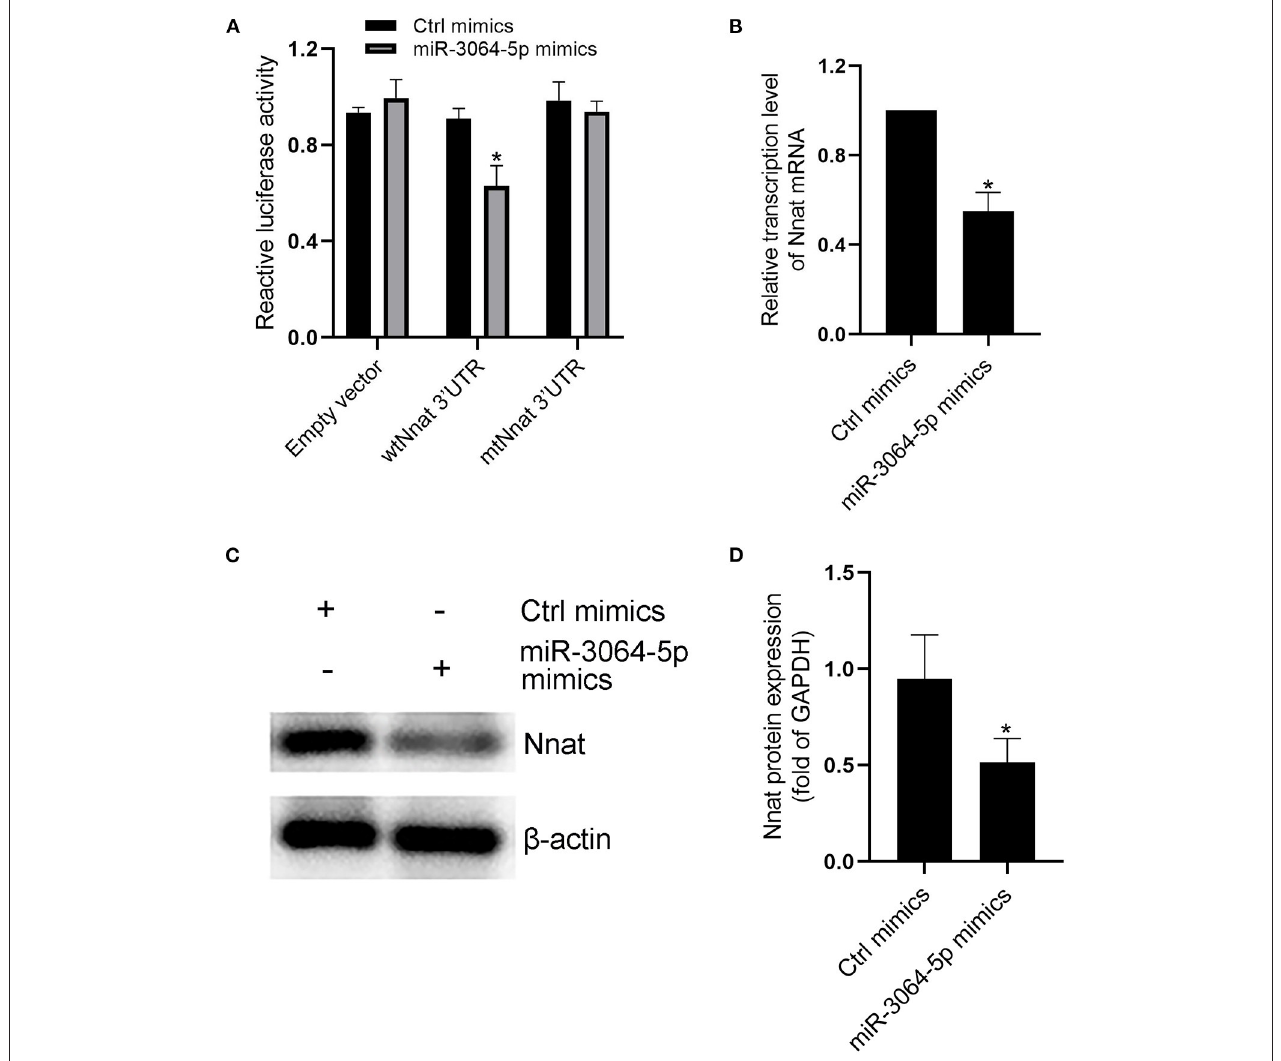
FIGURE 7 | Evidences that miR-3064-5p targeting Nnat. (A) The reporter constructs containing the WT or Mut Nnat 3 ′ UTR regions were co-transfected with control mimics or miR-3064 mimics plasmid into mature adipocytes. After 24h, firefly luciferase activity in each sample was measured and normalized to control luciferase activity. (B) The mRNA transcription level of Nnat after intervention of miR-3064-5p mimics. (C) The protein expression level of Nnat after intervention of miR-3064-5p mimics. (D) Semi quantitative analysis of western blotting in (C) . Data are presented as the means ± standard error of the mean for six independent experiments. * P < 0.05 vs. Ctrl